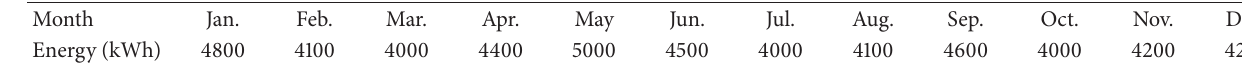
Table 3: Data collected on electricity bills of a school at Accra (2013).